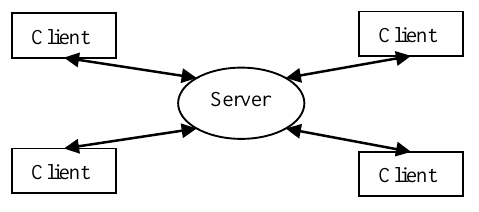
Figure 1. Client-server model